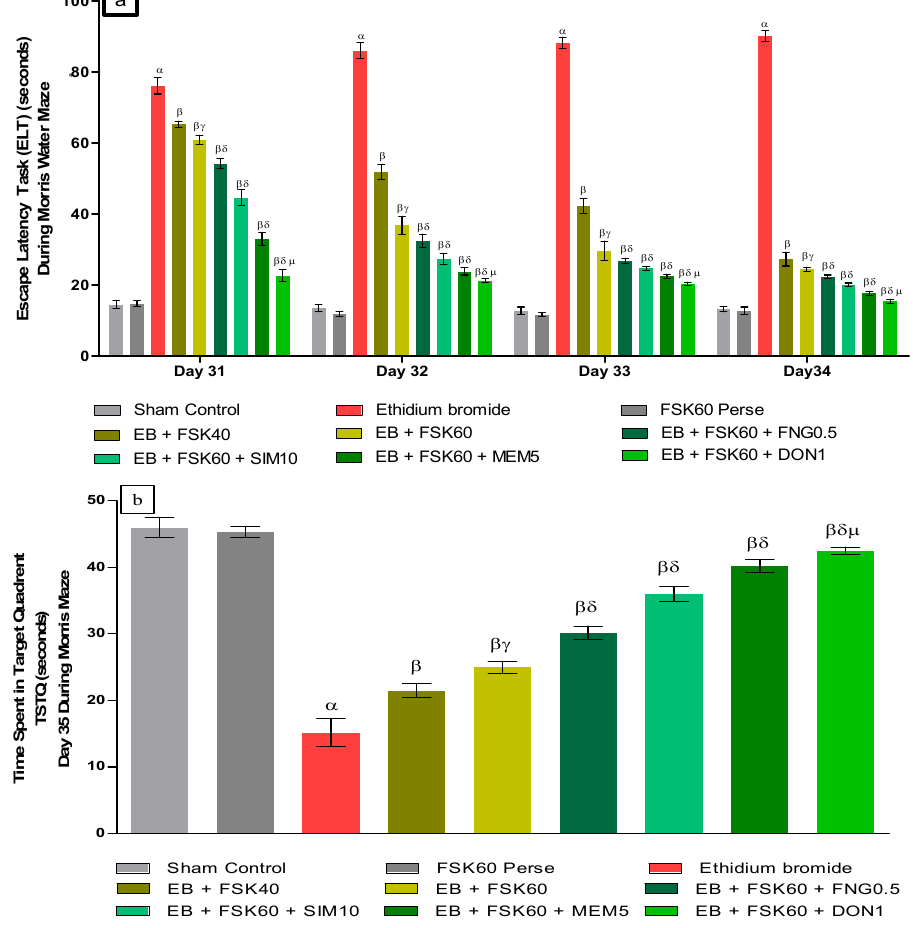
Figure 3. ( a ) Protective role of FSK on escape latency task during Morris water maze in experi- mental multiple sclerosis rats. ( b ) Protective role of FSK on time spent in targeted quadrant during Morris water maze in experimental multiple sclerosis rats. Analysis of Variance (ANOVA) with Tukey’s test was used to evaluate the data, which were presented as mean with SD ( n = 6). α EB (p < 0.01) v / s Sham control and FSK40 perse; β EB + FSK40, EB + FSK60, EB + FSK60 + FNG0.5, EB + FSK60 + SIM10,